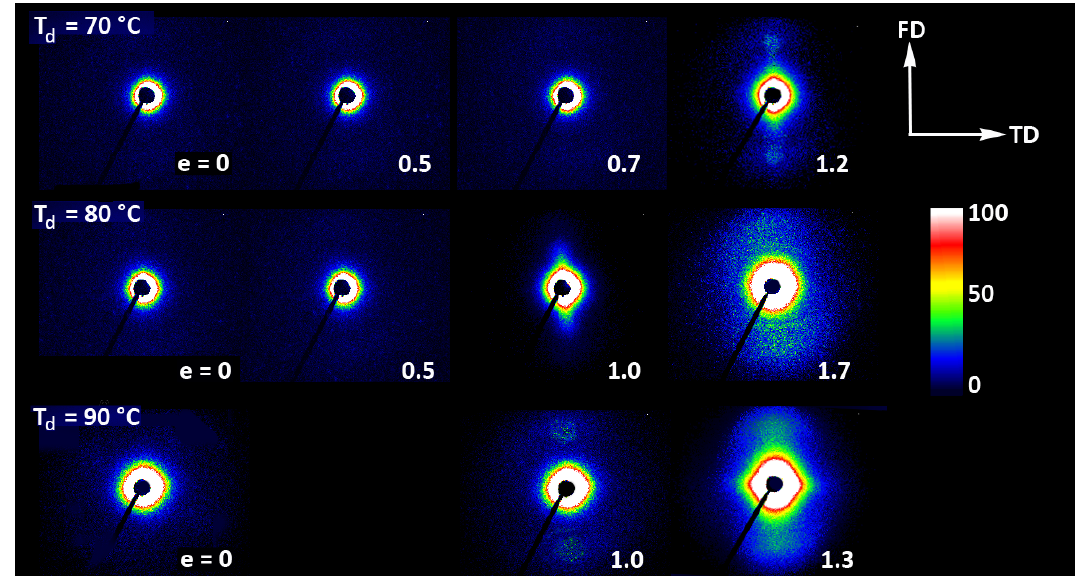
Figure 11. 2D-SAXS patterns of the initially amorphous A samples deformed in uniaxial tension at temperature T d = 70 °C ( top row ), T d = 80 °C ( middle row ), and T d = 90 °C ( bottom row ). The true strain indicated for each pattern is the local true strain calculated from the distance of the ink marks printed on the sample.